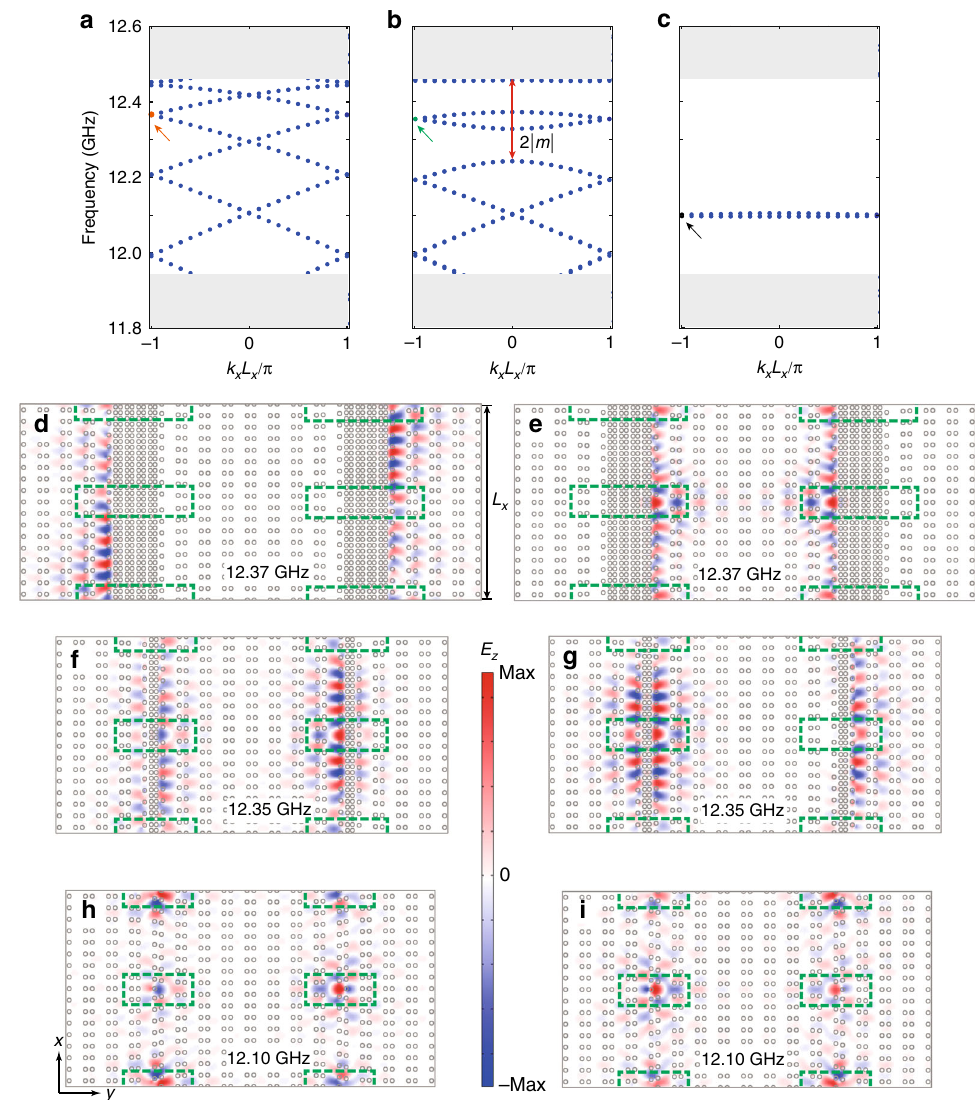
Fig. 4 Electromagnetic simulation of the gluing process. a – c Photonic spectrum during the gluing process with decreasing width of the chunk of the topologically trivial photonic crystal where L x ′ ¼ 4 a y ′ ; a y ′ ; 0, respectively. The shaded regions represent the bulk photonic bands. Within the bulk photonic band gap, there are photonic states associated with edge states and localized states bound to the dislocations. d , e The fi eld pro fi les of the degenerate photonic states labeled by the red arrow in a . f , g ( h , i ) The fi eld pro fi les for the degenerate states labeled by the green (black) arrow in b ( c ). The green boxes enclose the